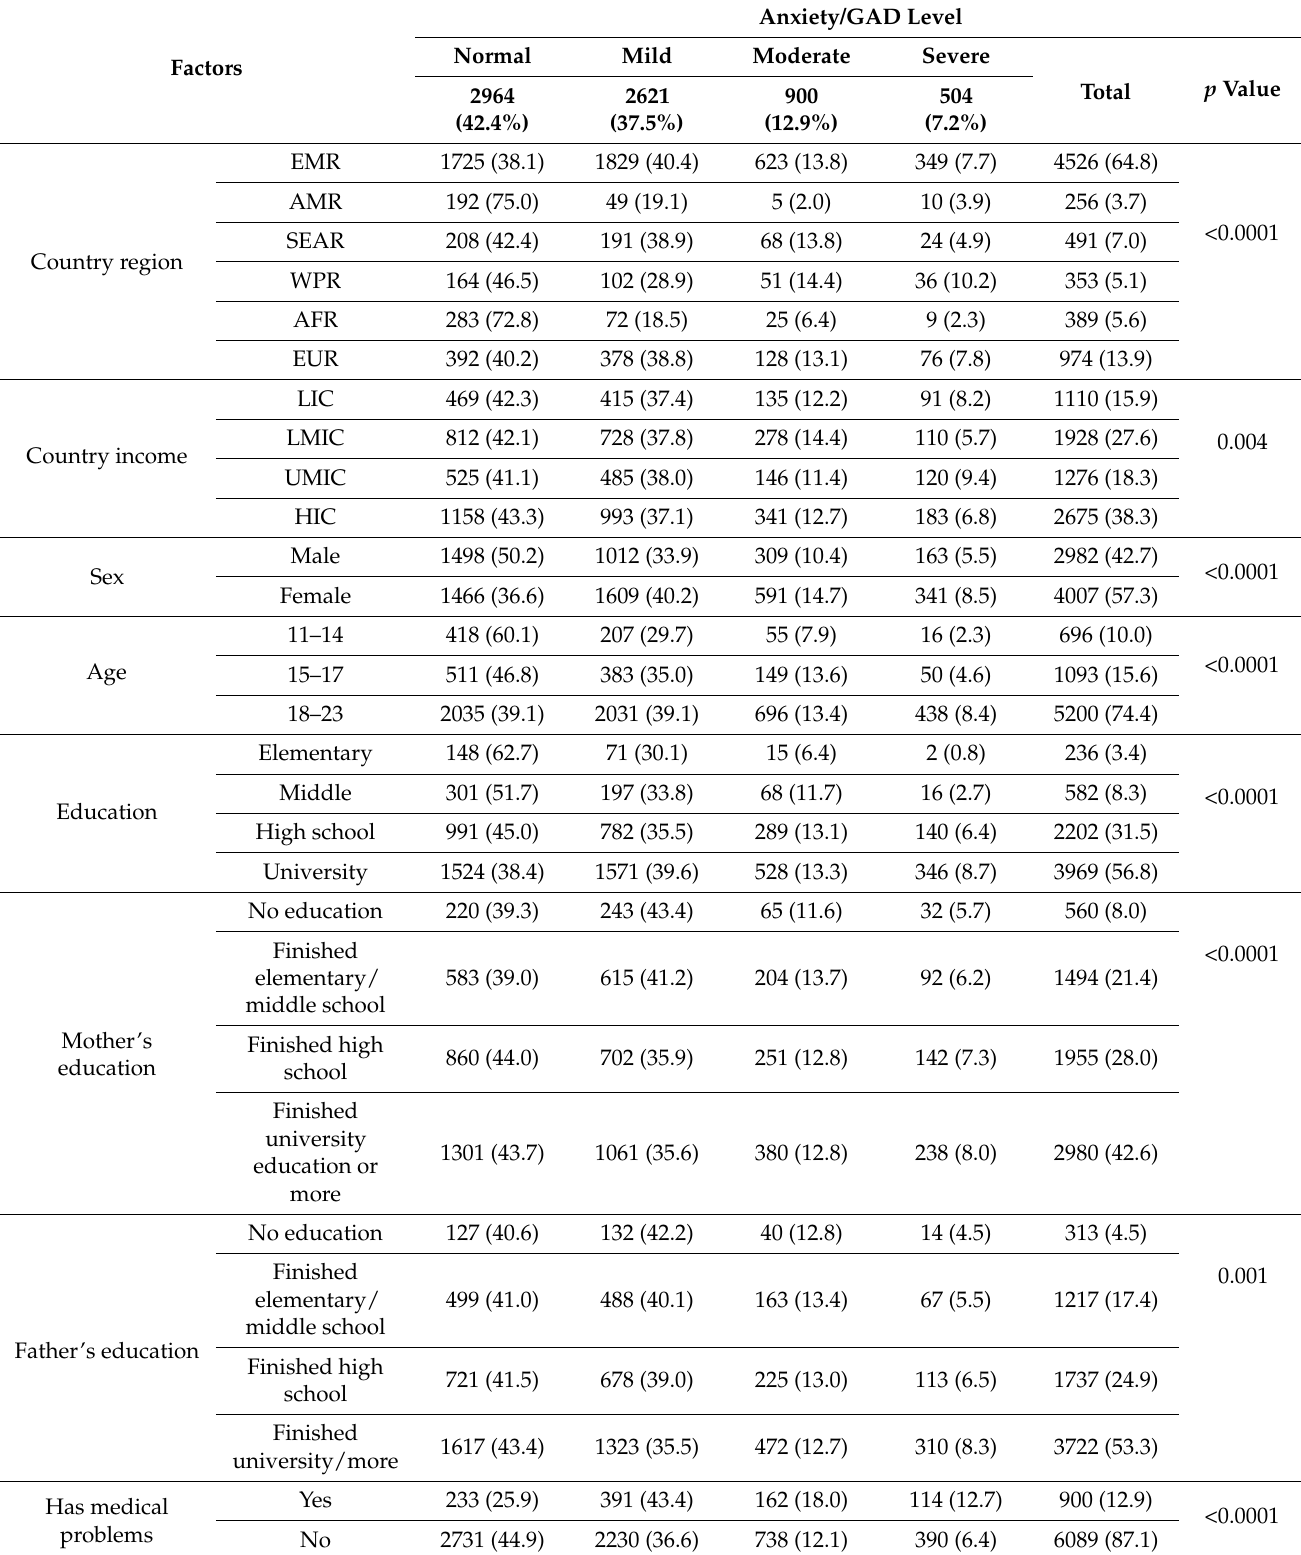
Table 1. Anxiety/GAD level, Country level factors, sociodemographic profile, medical history and COVID-19 status among 11 to 23-year-old individuals from different countries during the second wave of COVID-19 ( n =